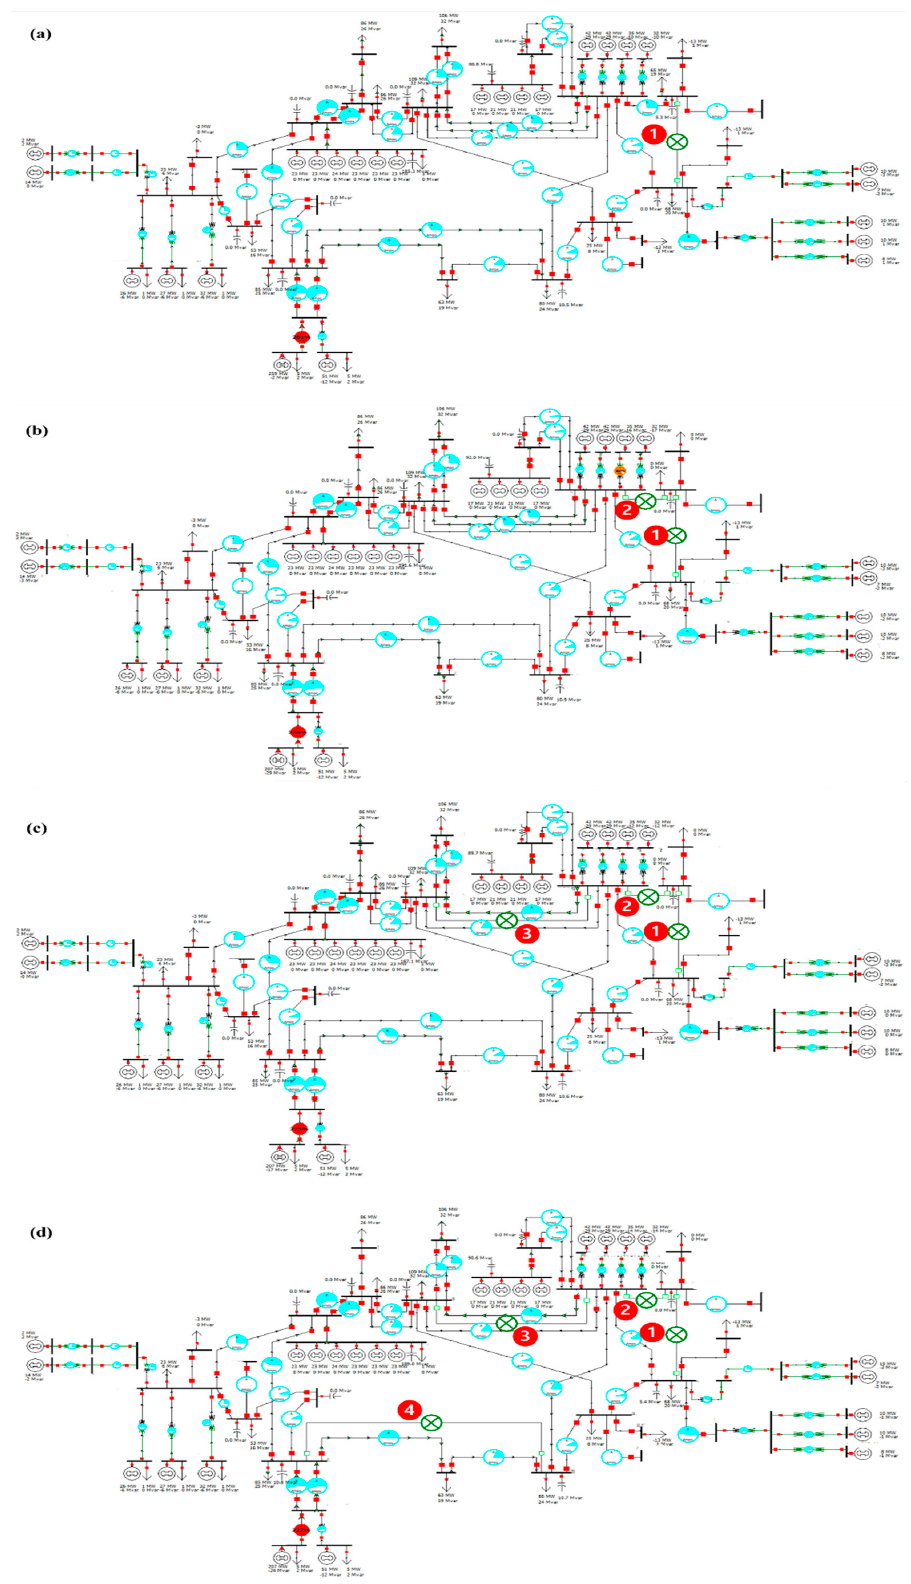
Figure 9. Systematic diagram with multiple contingency analysis; contingency analysis was conducted sequentially from ( a – d ).